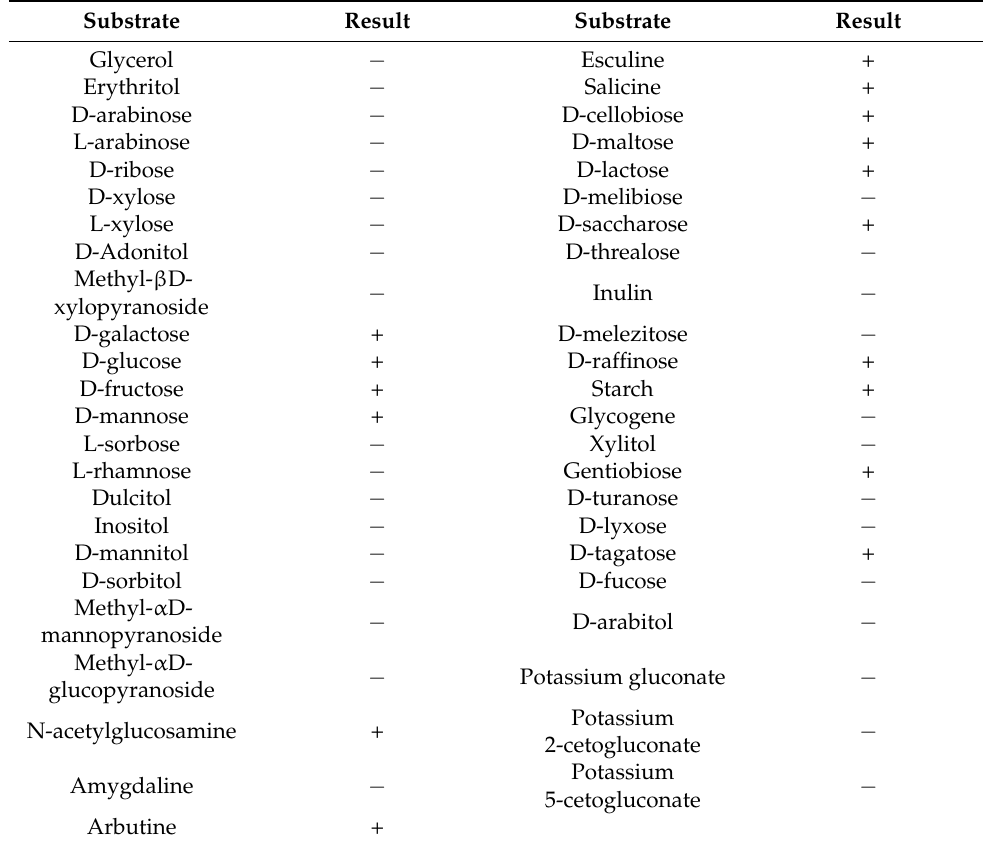
Table 2. Carbohydrate fermentation profile of CNCM I-4884 assessed by API 50 CH test strips.